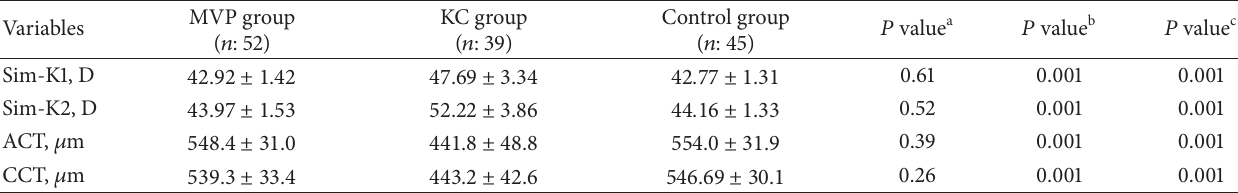
Table 3: Corneal topographical properties of the patients and the control groups.